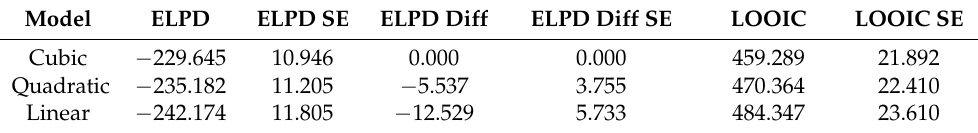
Table 3. Model comparison through the Leave-One-Out Information Criterion (LOOIC) for Bayesian models, based on the Expected Log Predicted Density (ELPD). Lower (absolute) ELPD and LOOIC values mean better fit. The middle columns correspond to the pairwise difference of ELPD against the model deemed initially better, which is displayed in the first row and therefore has a difference value of 0.